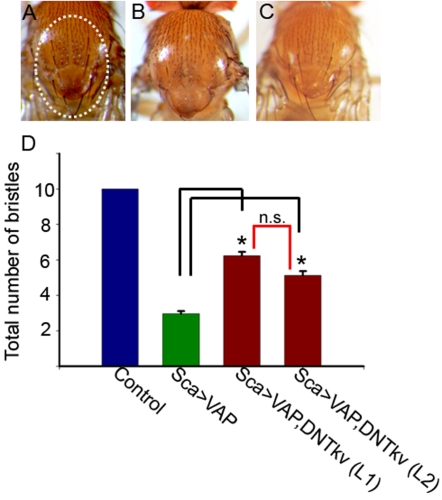
Genetic interaction between VAP and BMP signalling: Expression of dominant negative thickvein suppresses the VAPwt bristle phenotype.(A–C) Thoraces of control (A), sca-GAL4/VAPwt (B) and sca-GAL4/VAPwt, DNtkv animals (C). (A) In control animals, the bristles are invariant in number and position. Circled region indicates the 10 bristles used for analysis. (B and D) Expression of VAPwt using sca-GAL4 leads to loss of bristles. On average, 2–3 bristles are observed in these animals. (C and D) Expression of dominant negative thickvein (DN-tkv) results in a significant suppression of the bristle loss phenotype caused by overexpression of VAPwt (p<0.001, ANOVA with Sidak-Holm test). This was observed with two independent lines of DN-Tkv referred to as L1 and L2; an average of 6 and 5 bristles respectively, were observed in these animals (D). n.s., not significant.